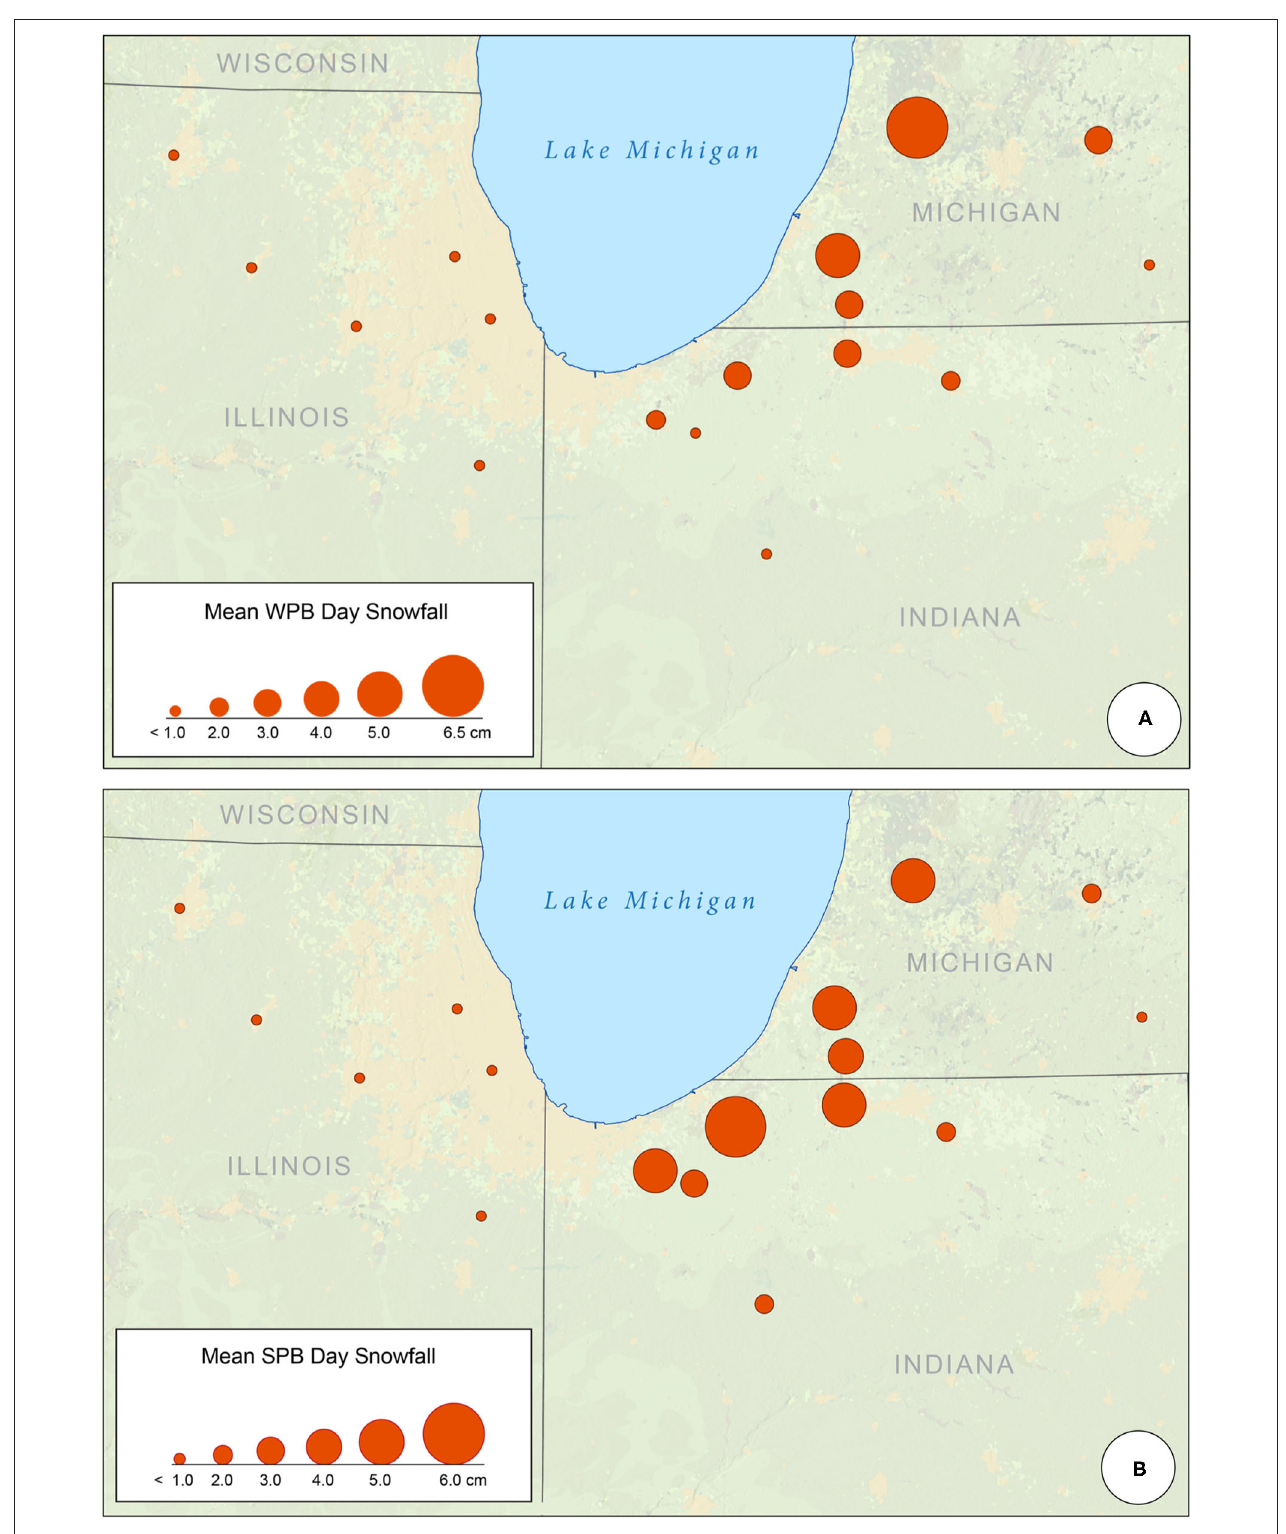
FIGURE 3 | Mean snowfall (cm day − 1 ) associated with WPB (A) and SPB (B) lake-effect snow days.